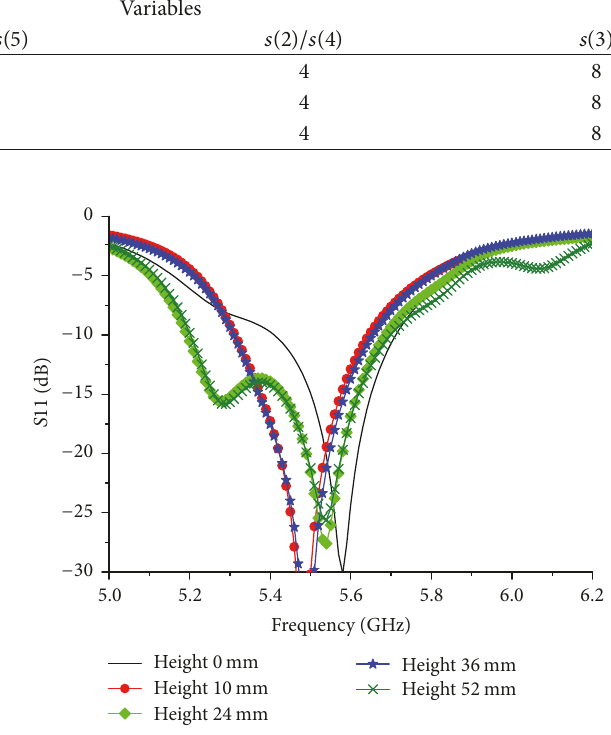
Figure 6: Parametric study of the cable height in the